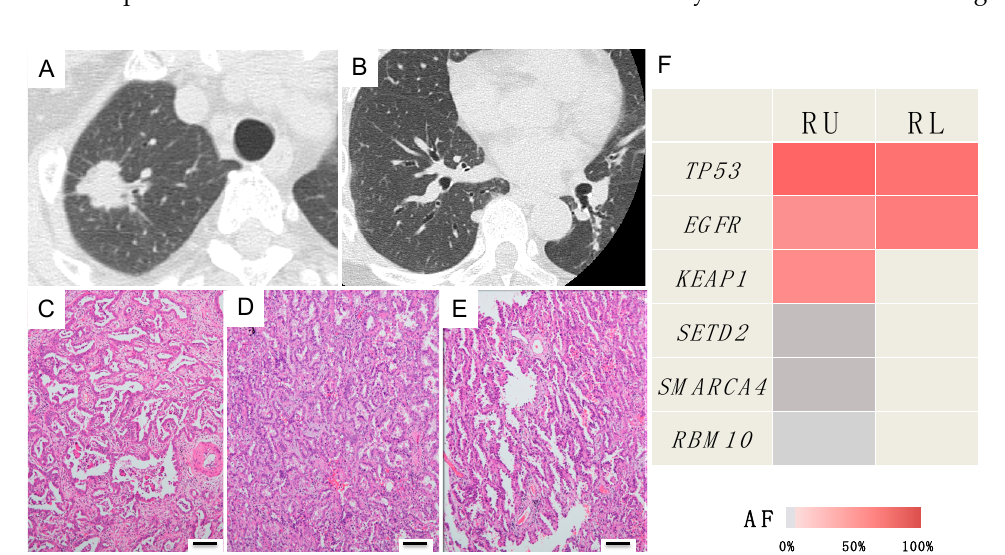
Figure 4. Radiological, histopathological and genomic findings in case B. ( A ) Lung cancer in the right upper lobe. ( B ) A small nodule in the right lower lobe. ( C ) Histology of the lung cancer in the right upper lobe. ( D , E ) Histology of the nodule in the right lower lobe. A lepidic pattern was observed in the periphery of the small nodule. Each scale bar indicates 100 μ m. ( F ) Heatmap of the gene mutations of the two lung tumors. The significant mutations identified in the right upper lobe tumor were homologous with those detected in the right lower lobe tumor. RU, right upper lobe; RL, right lower lobe; AF, allele fraction